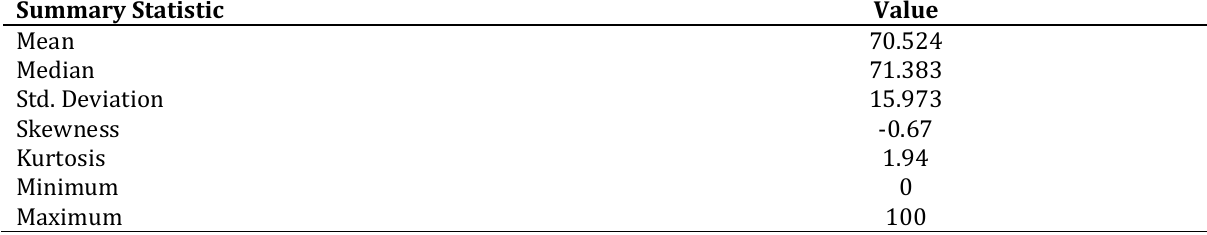
Table 12: Summary statistics of the level of sensitivity for the Internet of things (IoT)